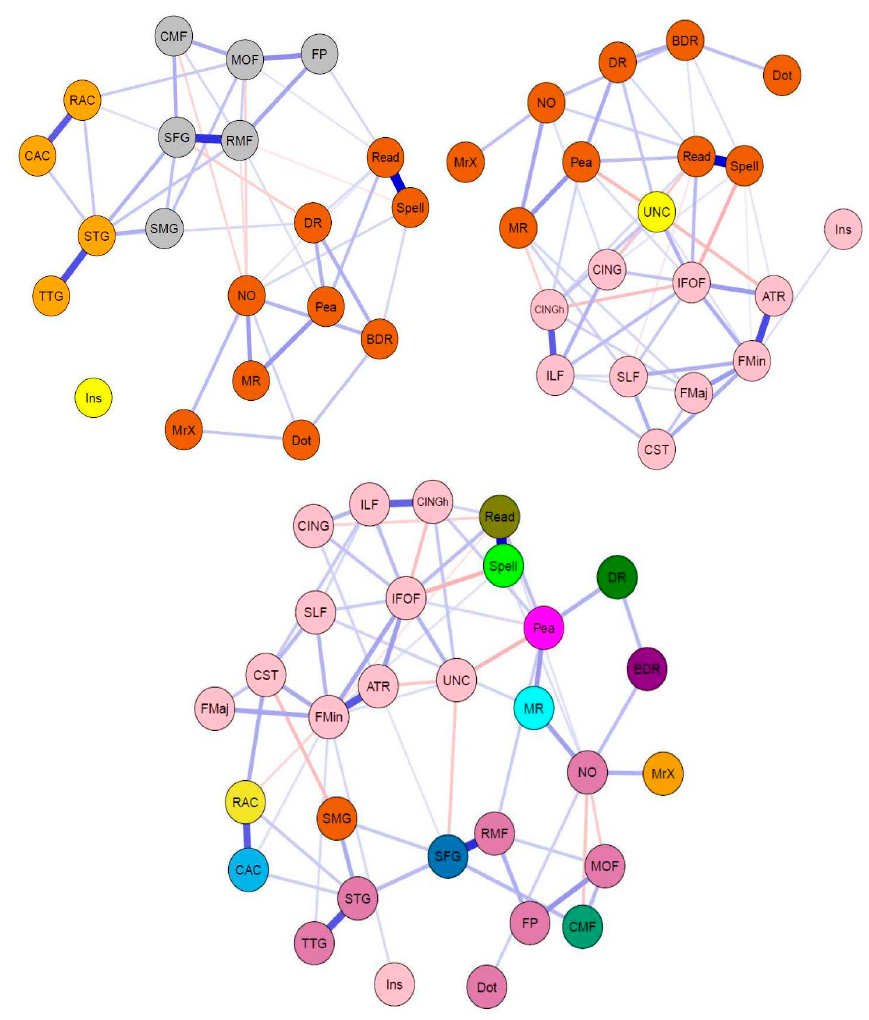
Figure 4. Network visualizations (spring layout) of partial correlation multilayer networks for CALM data. Colors indicate groups determined by the Walktrap algorithm (see above). ( Top ) Bi-layer networks consisting of cognition and grey matter ( top left ), and cognition and white matter ( top right ). ( Bottom ) Tri-layer network consisting of cognition, grey matter, and white matter ( center ). Regarding centrality, we report bridge strength (Figure 5). In the cognitive-grey mat- ter network, three bridge nodes surfaced (in descending order: superior temporal gyrus, superior frontal gyrus, and rostral middle frontal gyrus, Figure 5, top left). In terms of stability, the CS coefficient was 0.20, indicating that the bridge strength estimates were unstable under bootstrapping conditions. In the cognitive-white matter bi-layer network, three nodes (in descending order: uncinate fasciculus, inferior frontal-occipital fasciculus, and hippocampal cingulum) emerged as possible bridge nodes (Figure 5, top right). More- over, the centrality estimates had a CS coefficient of 0.13, once again suggesting that the bridge strength estimates were unstable. Lastly, for the tri-layer network, five nodes dis- played positive bridge strength equal to or greater than one standard deviation above the